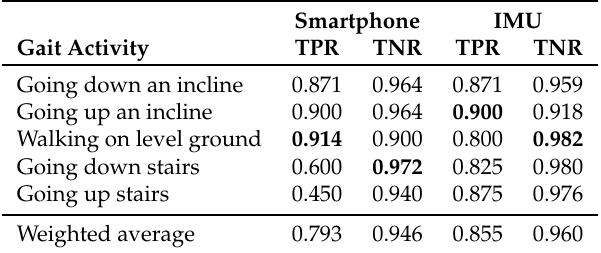
Table 2. Classification results for each gait activity using the data treatment acc FD + acc XYZ and the KNN algorithm. TPR = true positive rate; TNR =true negative